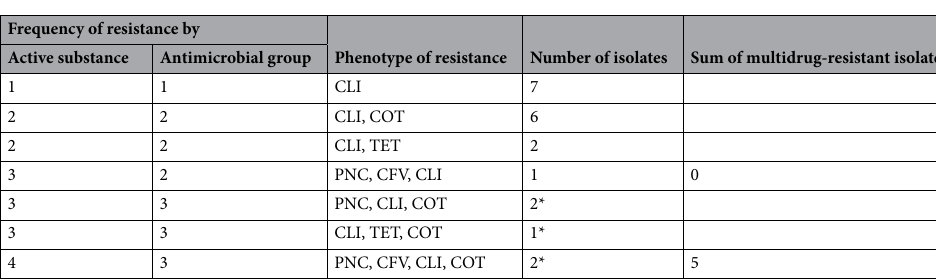
Table 4. Resistance profiles for Gordonia species mastitis isolates (n = 21). CLI clindamycin, COT sulfamethoxazole/trimethoprim, TET tetracycline, PNC penicillin G, CFV cefovecin; *Multidrug resistant isolates, i.e. resistance to ≥ 3 groups of